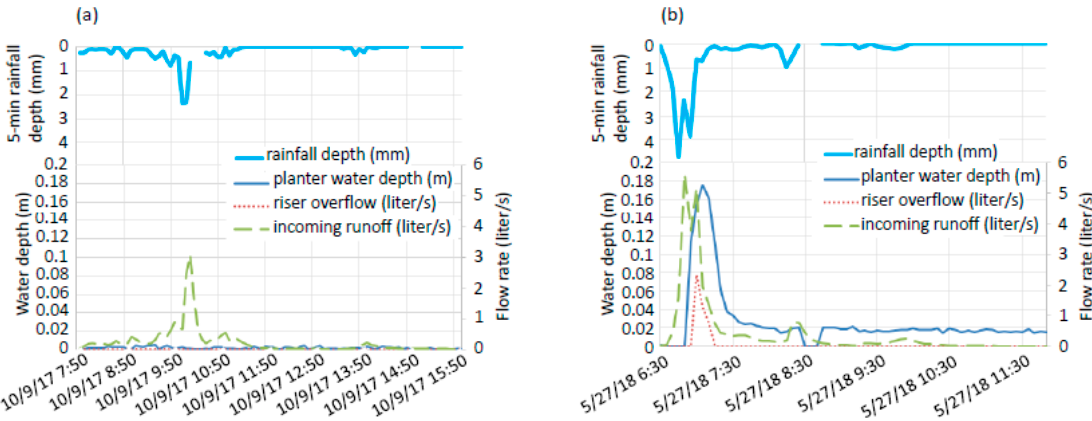
Figure 5. Comparison of hydraulic responses of planter #1 from ( a ) a low-intensity storm with rainfall depth of 15.2 mm (9 October 2017) and ( b ) a high-intensity storm with rainfall depth of 19.8 mm (27 May 2018).